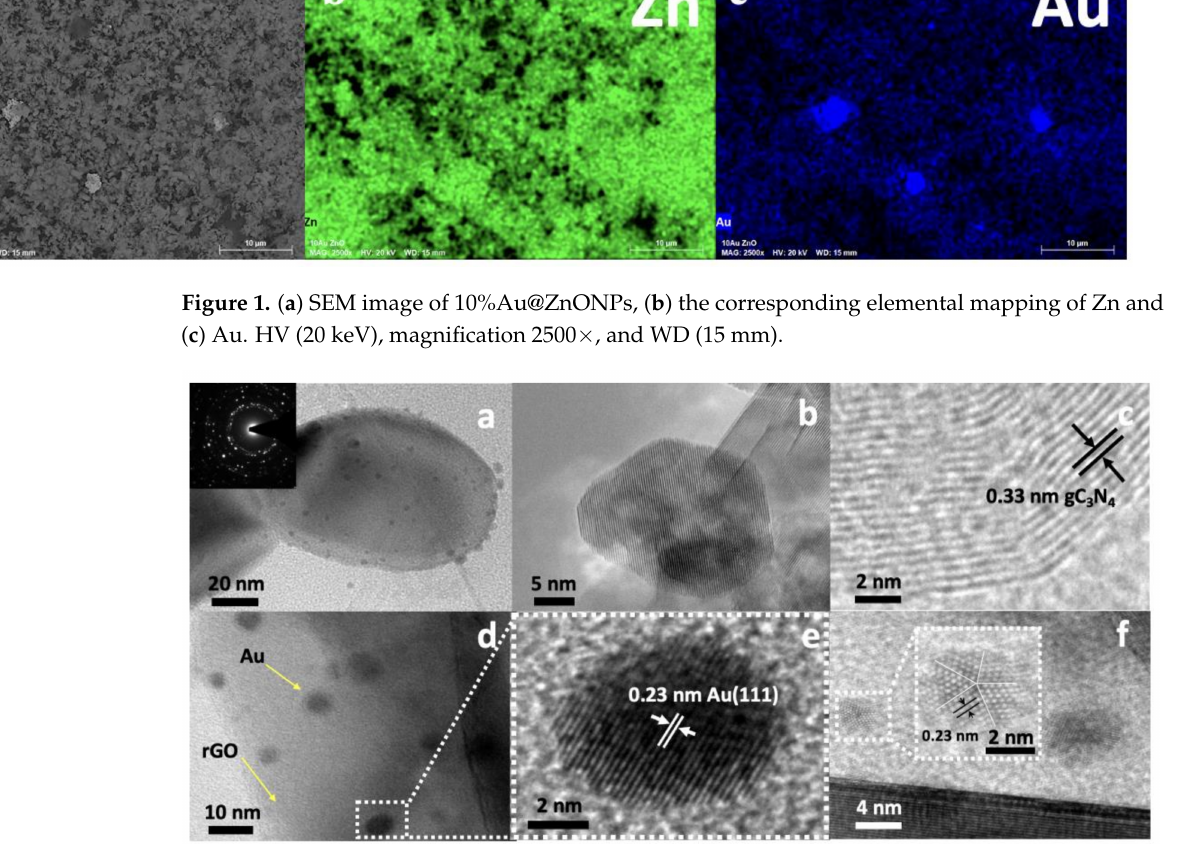
Figure 2. ( a ) TEM and ( b – f ) HR-TEM images of 10%Au@ZnONPs-3%rGO-3%gC 3 N 4 . ( a ) Low magnification and SAED pattern of the heterostructure; ( b ) magnified image of a ZnO nanoparticle; ( c ) crystalline structure of gC 3 N 4 ; and ( d – f ) images at different magnification of